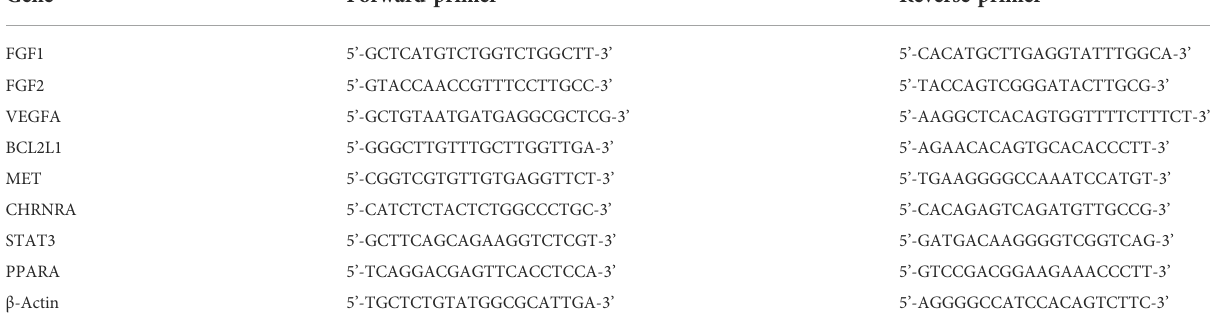
TABLE 2 Primer sequences for Q-PCR